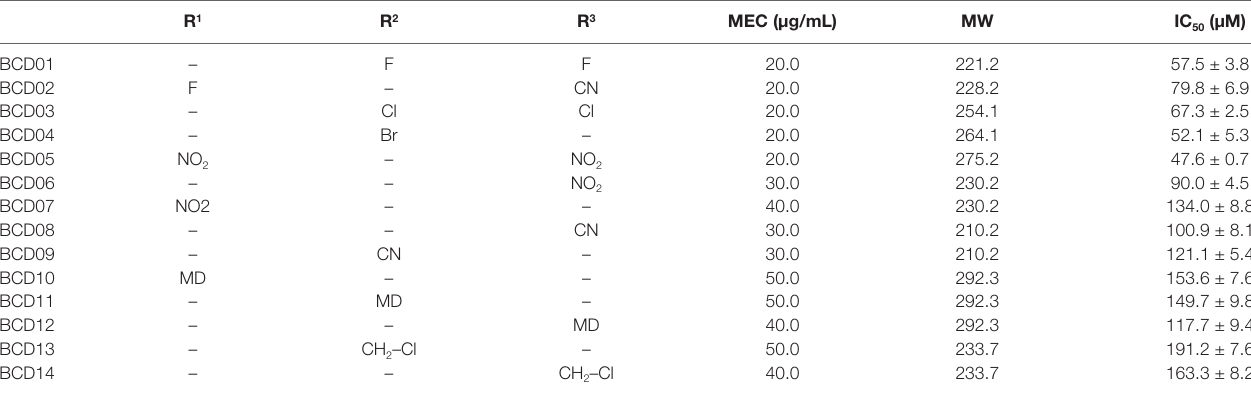
R 1 –R 3 : ortho-, meta- and para-position of the substitutional group on the benzene ring. F, Cl, Br: halogen substitutional group. CN: cyan group. NO 2 : nitro group. “–”: no substitutional group. Experiments were performed twice with three biological replicates.